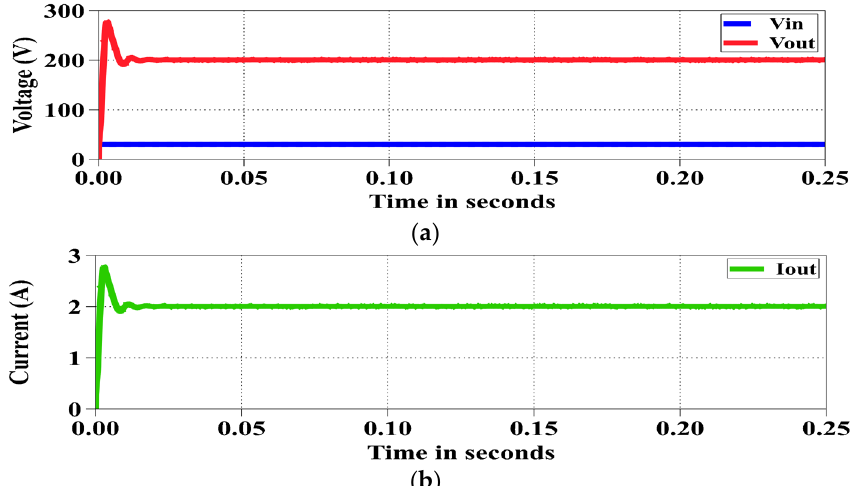
Figure 9. Current and voltage waveforms: ( a ) Output voltage; ( b ) Output current.